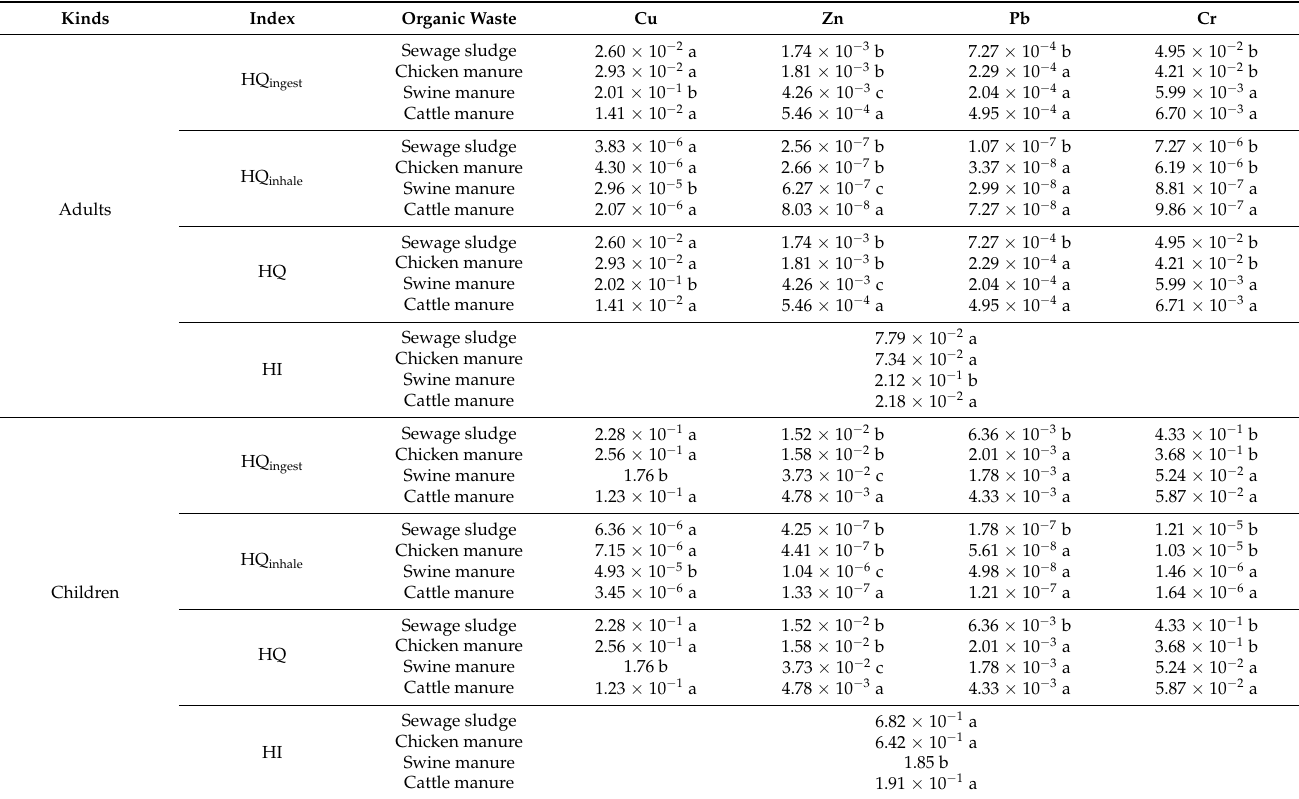
Different lower-case letters indicate the results of multiple comparisons between different organic